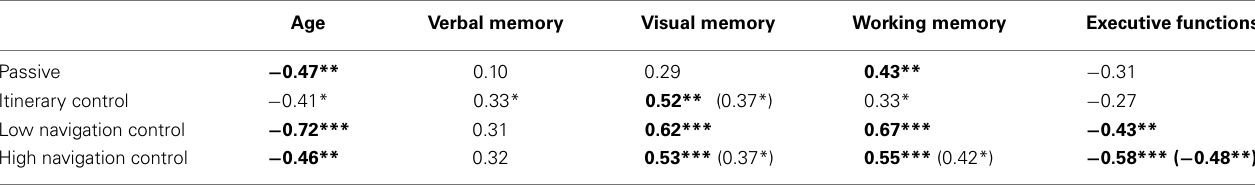
Table 3 | Correlations betweenVR binding mean scores and neuropsychological tests as a function of condition ( n = 36 per condition)